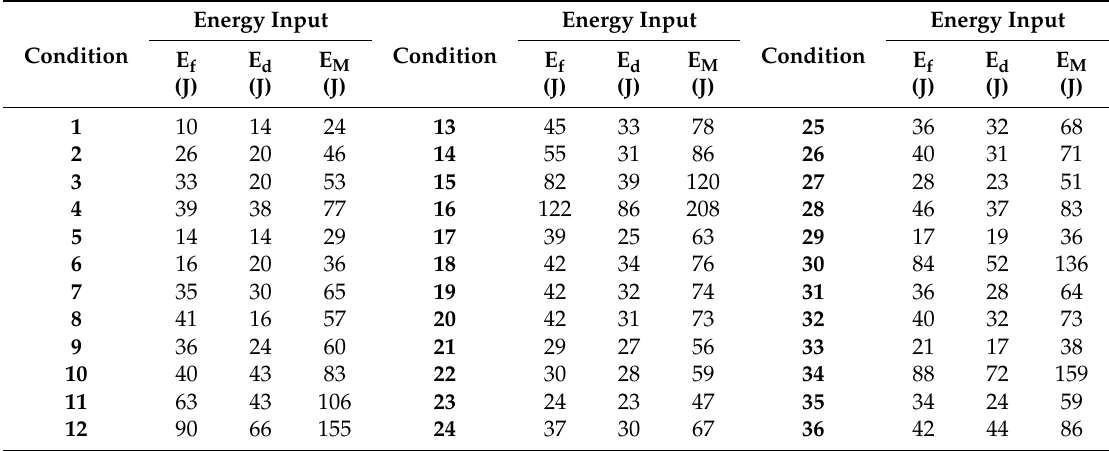
Table 4. Energy input determined for the investigated set of joining conditions.